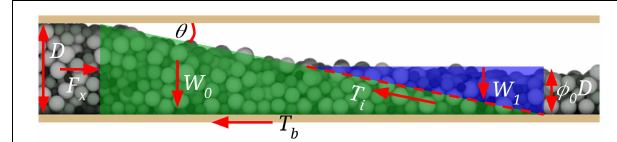
FIGURE 4 | Limit equilibrium of the transition zone. For the pile to be displaced by a force F x , two forces must be overcome; T b , the basal traction due to the weight W 0 of the green region, and the x component of the internal sliding traction T i along the assumed failure surface denoted by the dashed line, due to the normal component of the weight above the failure surface, W 1 , of the blue